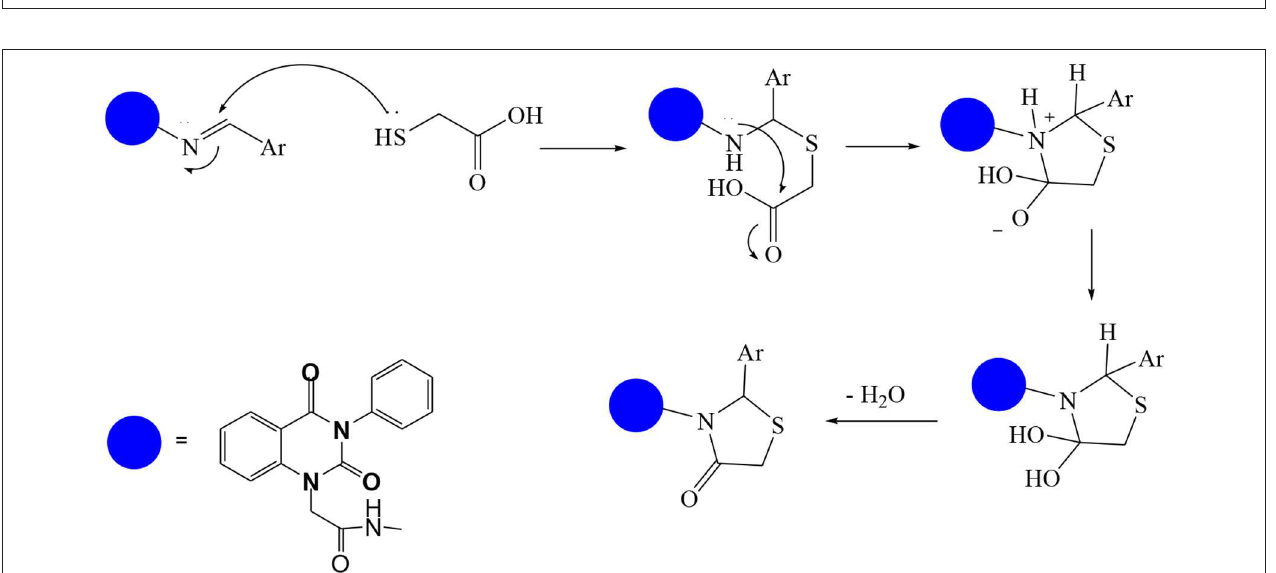
SCHEME 3 | Reaction protocol for the synthesis of compound 4a